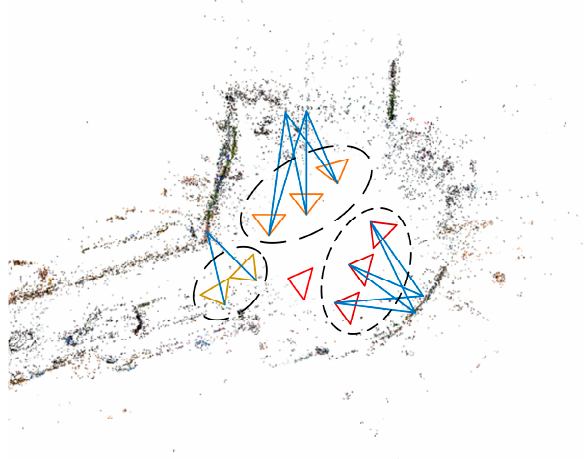
Figure 4. Covisibility clustering. Cameras are clustered into three clusters marked by different colors, where the red is the camera of the query